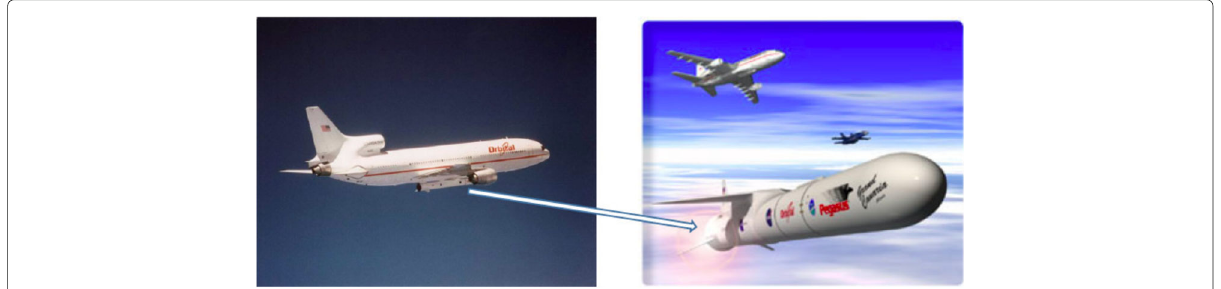
Fig. 15 Pegasus airborne launcher before and after release. (Sources : air-and-space.com /